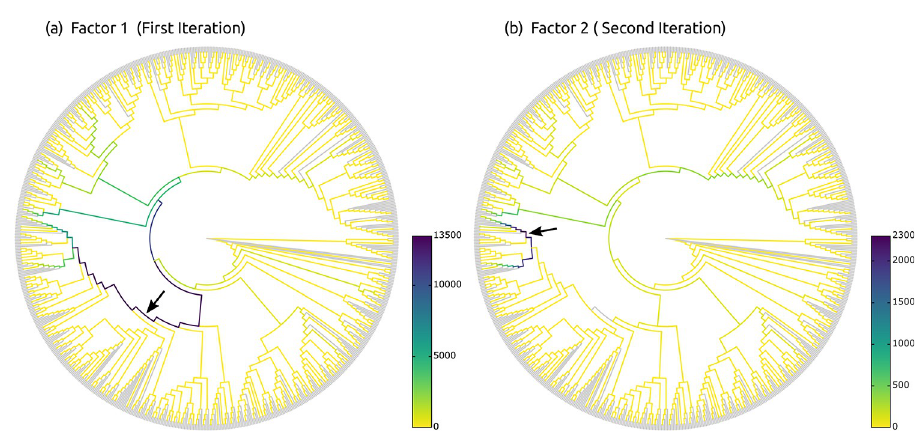
Fig 10. Objective values of Placement-Factorization of the BV dataset. Here, we show the values of the objective function for each inner edge, for the first two factors found by Placement-Factorization (with taxon weights) of the BV dataset. The winning edge of each iteration is marked by a black arrow. This novel visualization of phylogenetic factors helps to understand why a particular edge was chosen in an iteration: Here, the objective function of the first iteration in (a) yields high values for the path towards the Lactobacillus clade, consistent with previous findings. However, due to small differences, the winning edge of the first iteration is chosen to be relatively basal in the tree, meaning that a large clade is factored out. This obfuscates the fact that this factor is mostly concerning the Lactobacillus clade, and not so much the remaining taxa in that clade. This visualization thus aids interpretation of the found clades, and allows to identify the parts of a factored clade that are most relevant to the factor. In the second iteration in (b), the tree clearly shows the distinction between the two relevant clades of Lactobacillus again, consistent with previous findings. See also S15 Fig for the version of this visualization without taxon